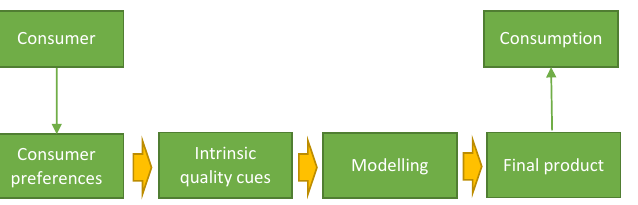
Figure 3. Sequence of steps often used for modelling the effect of consumer preferences in the final